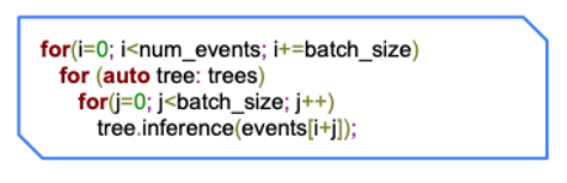
Fig. 6. Speedup in inference by adopting the JIT and the tree ordering techniques, in comparison to vanilla XGBoost